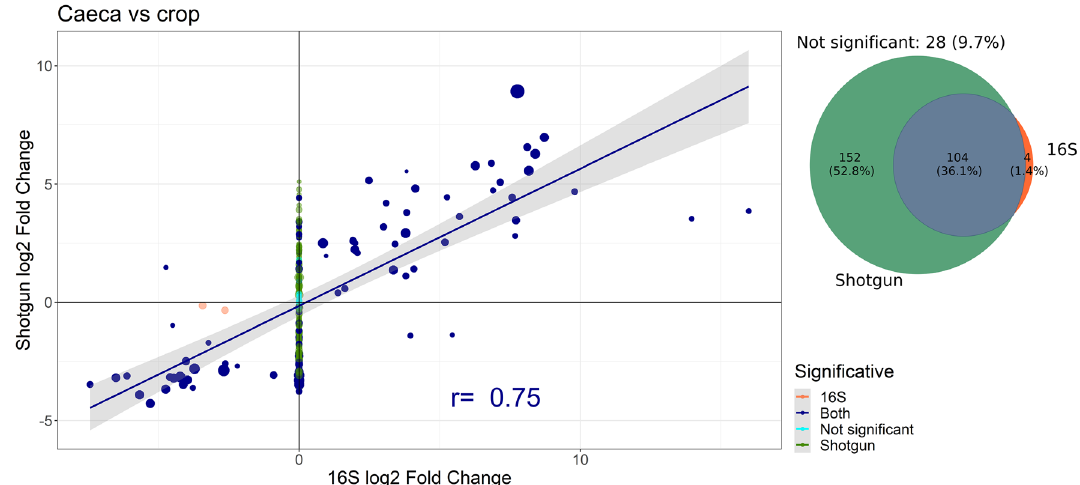
Figure 3. Fold changes between caeca and crop in genera identified by both strategies. Some fold changes are shrunk toward zero by the DESeq2 algorithm (see “Methods” section). Points with a statistically significant change for both strategies are represented in blue, for shotgun only in green, for 16S only in orange and without a significant change in cyan (adjusted P > 0.05 with DESeq2). Point size is the log 10 of average number of reads from shotgun strategy mapping to each genus. Pearson’s correlation coefficient r and regression line are computed only on points with statistically significant fold changes according to both strategies (“Both” group in figure legend and in Table 1).